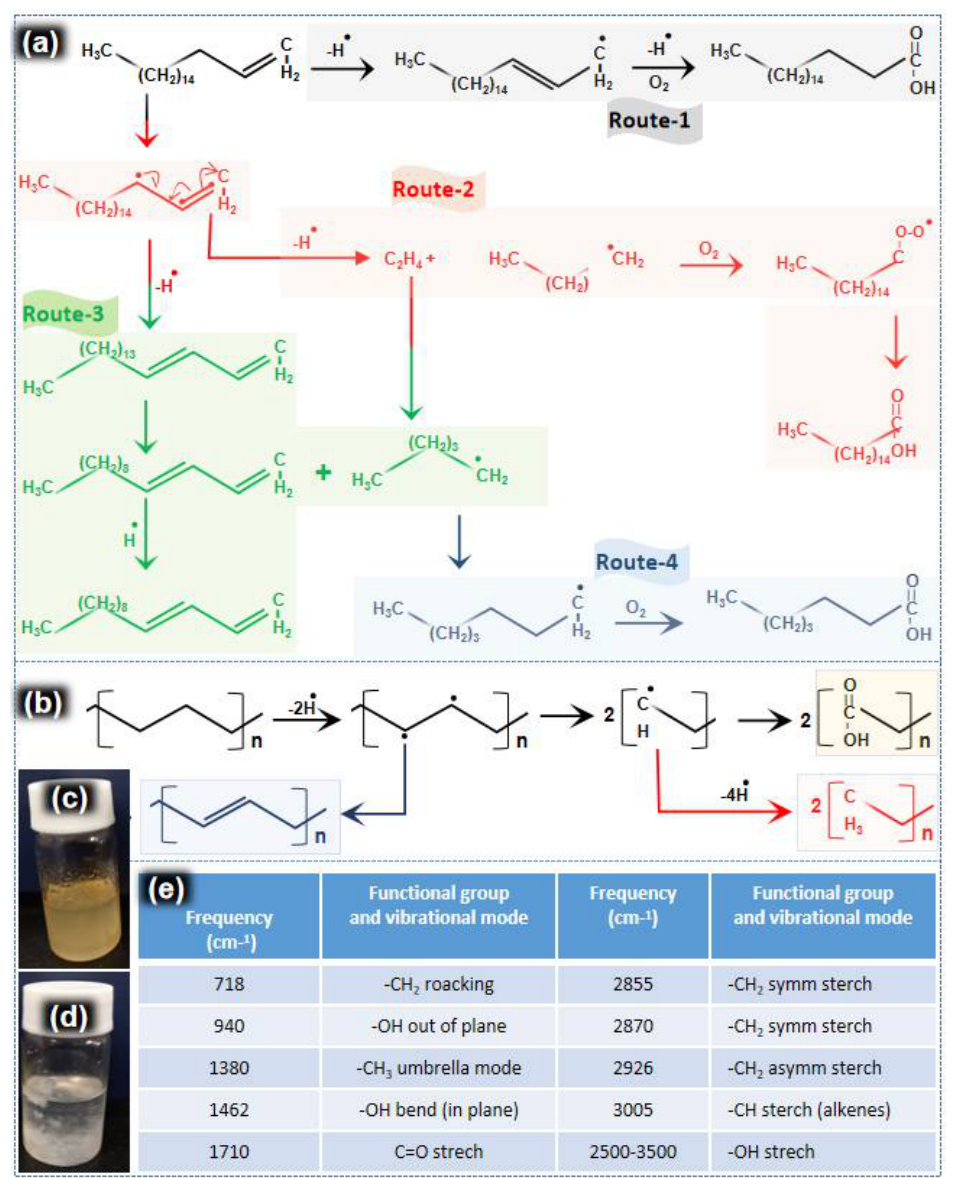
Figure 3. ( a ) Proposed mechanism of degradation of 1-octadecene, ( b ) PE, ( c ) oil precursors, ( d ) wax (suspended in acetone) produced by the degradation process and ( e ) FTIR analysis of the final product (oil precursors with a trace amount of wax).